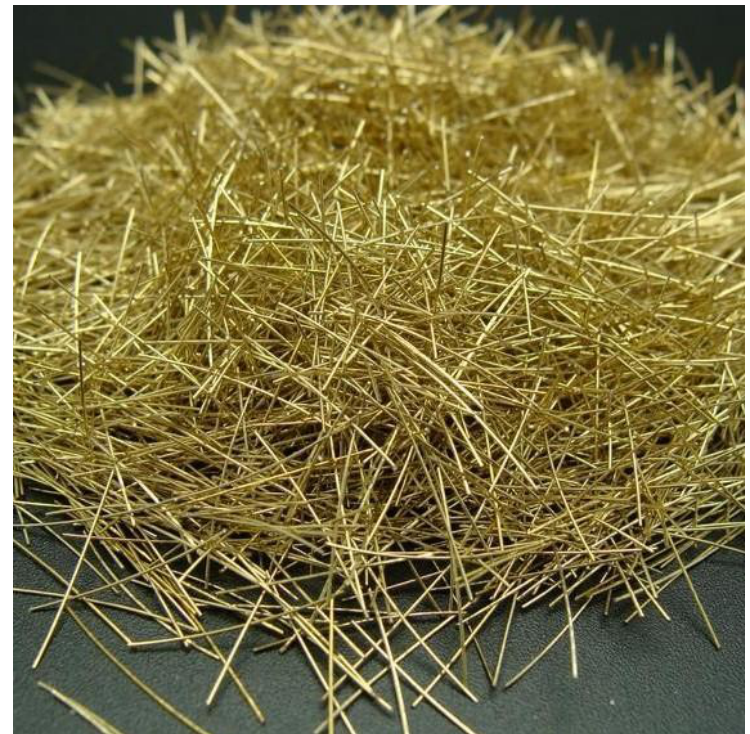
Figure 1. Steel fiber for the RPC axial tensile test.